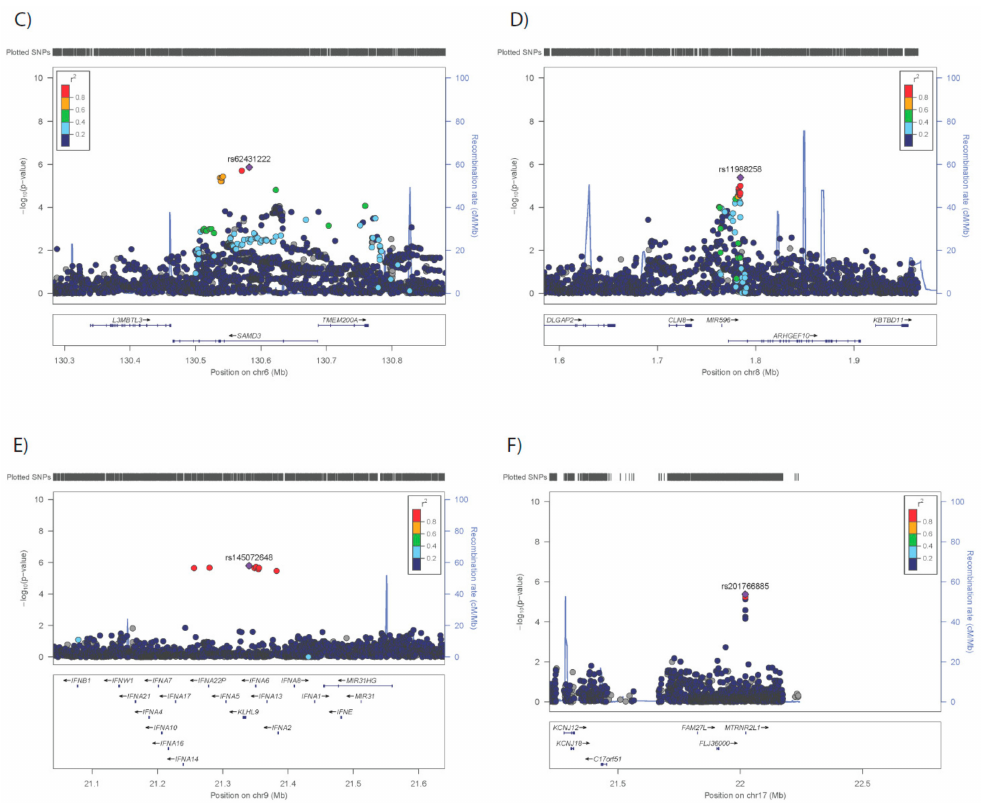
Figure 1. Genetic loci demonstrating suggestive association with adipose morphology.